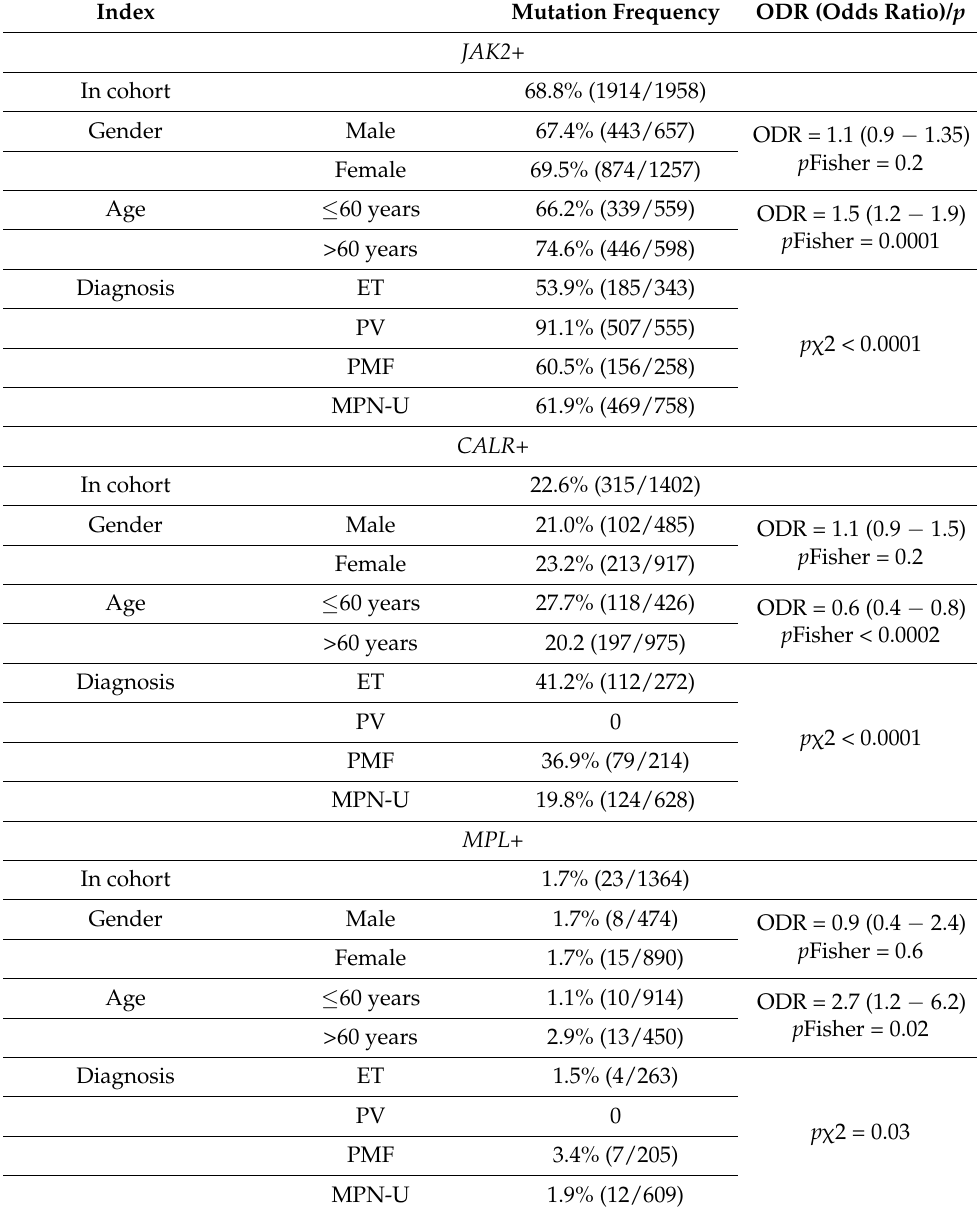
Table 1. General characteristics of the study cohort of patients. p -value from Fisher’s test was used to estimate significance for the tables of 2 × 2 and χ -square for the tables of higher dimensions (2 × 3, 2 ×